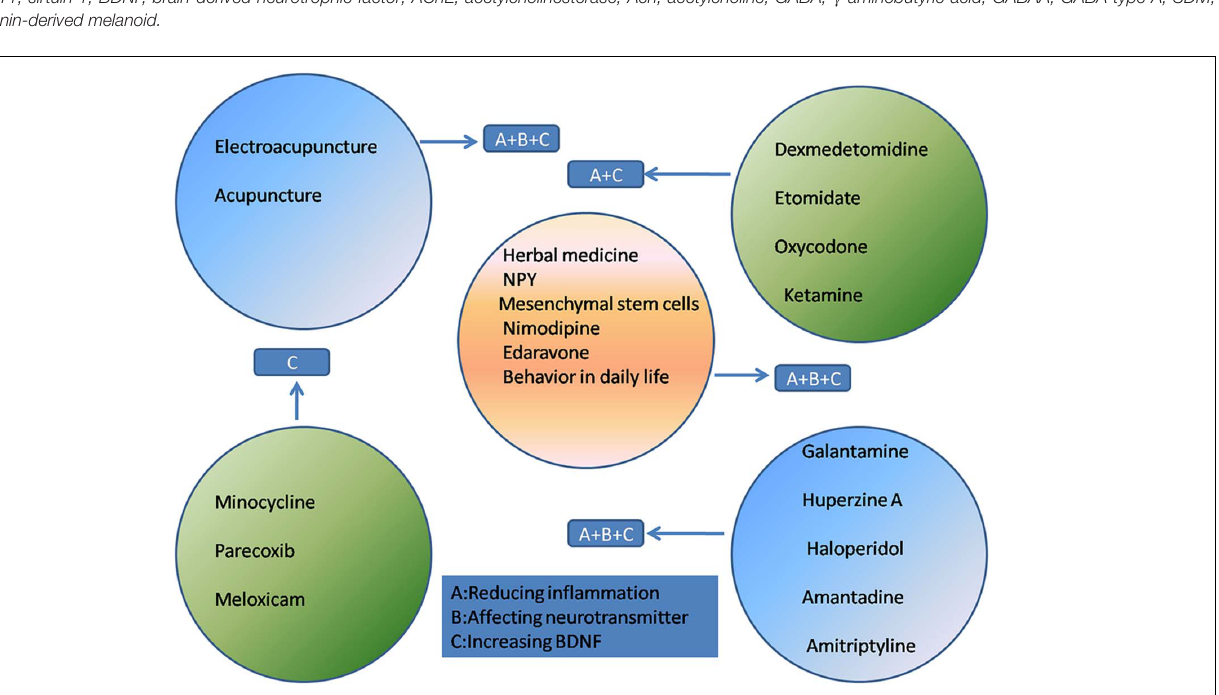
FIGURE 2 | The treatment and mechanism of